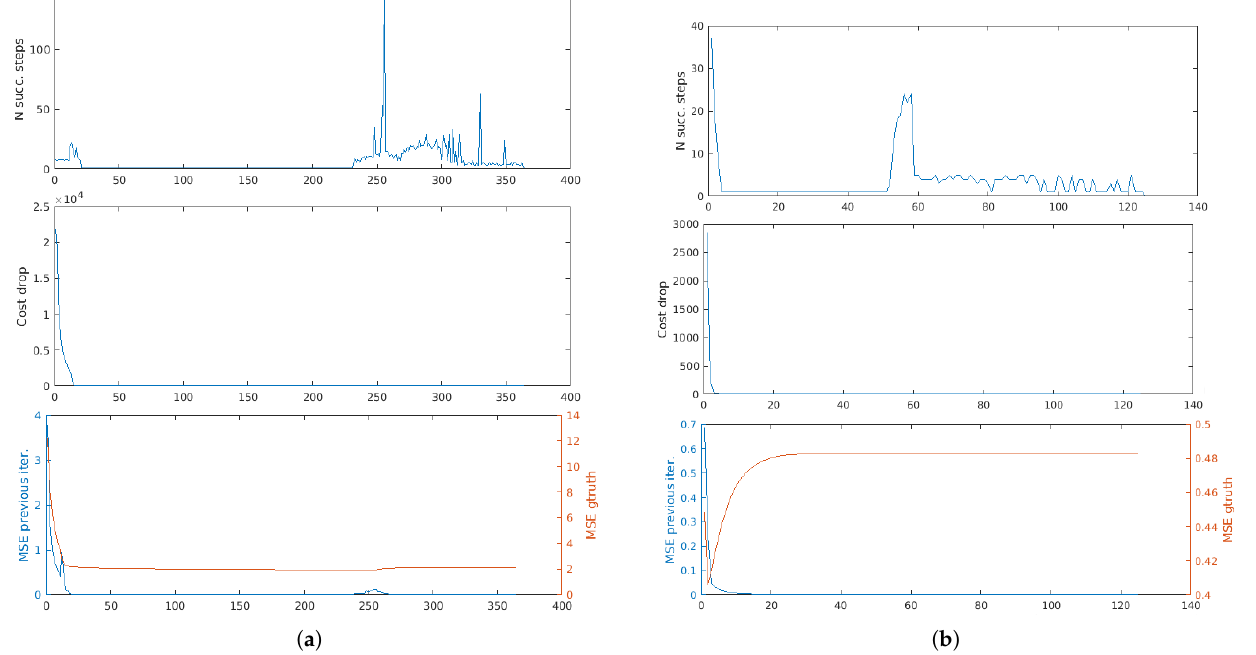
Figure 5. Termination criteria for the Bremen Dataset with ( a ) a small rotation ( b ) a small translation applied. As an example, we show the results on two point clouds from the Stanford Bunny dataset, whose initial misalignment is a rotation of 90 ◦ around the vertical axis, (Figure 6a), and a rotation of 180 ◦ around the vertical axis (Figure 6b). In these cases, it can be seen that the cost drop stabilizes much earlier than the MSE w.r.t. the ground truth. This behaviour, indeed, is desirable, since it appeared only in unsuccessful alignments, during which stopping earlier is an advantage (going further would be only a waste of computational